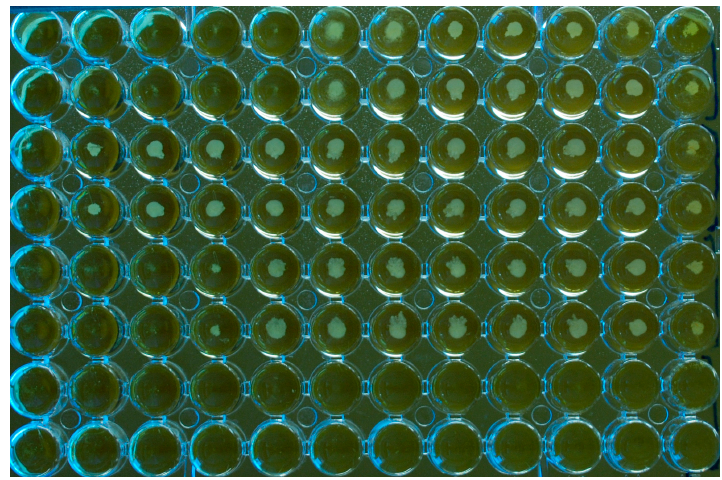
Figure 3. Microplate (U-bottom wells) for susceptibility testing of a M. pachydermatis isolate against three antifungal drugs tested in duplicate, MCZ (rows 1 and 2); TBD (rows 3 and 4); CTZ (rows 5 and 6). Growth medium: Christensen Broth with Tween 40 and 80 as a lipid source. The last column on the right comprises the drug-free growth controls. The last column on the left is the negative control (no yeast inoculum; no drug) and the two bottom rows are also inoculum free. The rows of wells contain doubling dilutions of the drugs from 16 to 0.03 µg/mL with the highest concentration to the left of the plate. For this experiment, the MICs were 2, >16, and 4 µg/mL, respectively, for MCZ, TBD, and CTZ. The plate was not agitated prior to reading. It can be seen how the yeast isolate formed button-like deposits in the wells.